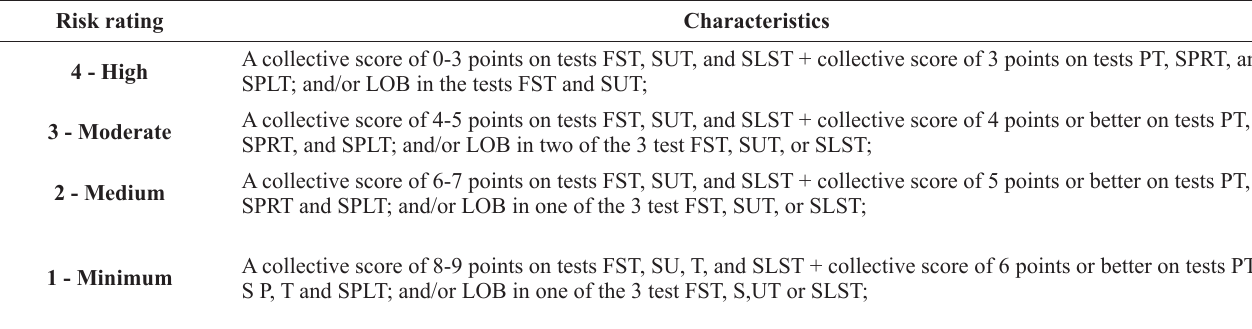
Table 1 - Calculation of the final score DMA ™